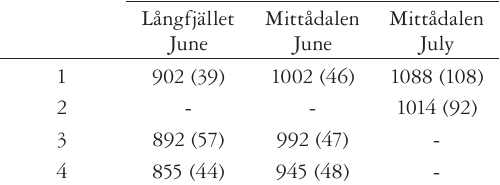
[in meter (with standard deviation s )] observed during the aerial survey. Weather classes are defined in Table